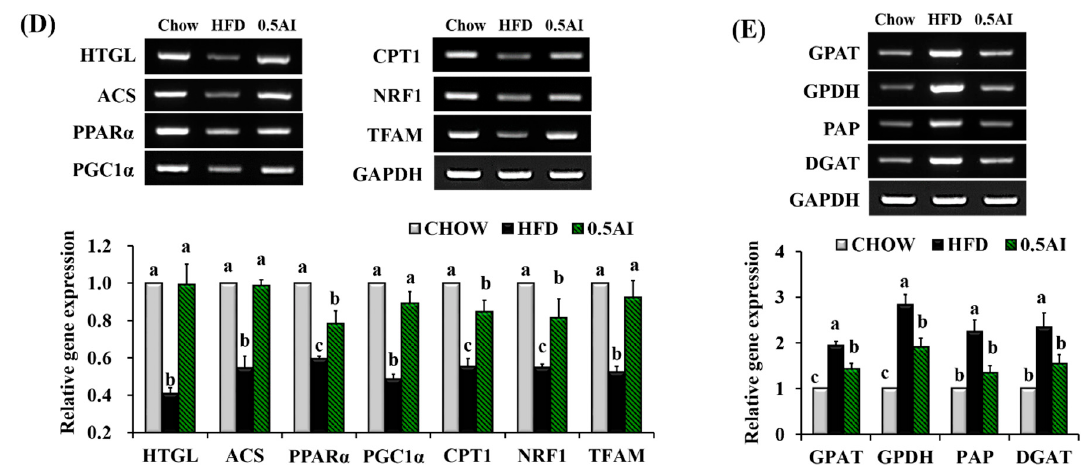
Figure 4 Figure 4. AI activates adiponectin-AMPK mediated signaling pathways in mice. ( A ) Plasma adiponectin concentrations; ( B ) representative western blot analysis and quantification of AdipoR2, total adenosine monophosphate-activated protein kinase (AMPK), p-AMPK, total S6K1, and p-S6K1 in the liver; Representative reverse transcription polymerase chain reaction (RT-PCR) product bands and quantitative comparison of mRNA expression for ( C ) lipogenesis, ( D ) lipolysis, fatty acid oxidation, inflammation and ( E ) triglyceride synthesis in the liver. Results are presented as the mean ± SEM. Statistical analysis was performed using one-way ANOVA and analyzed further by Duncan’s multiple range test. Different letters above the bars indicate significant differences among experimental groups ( p <